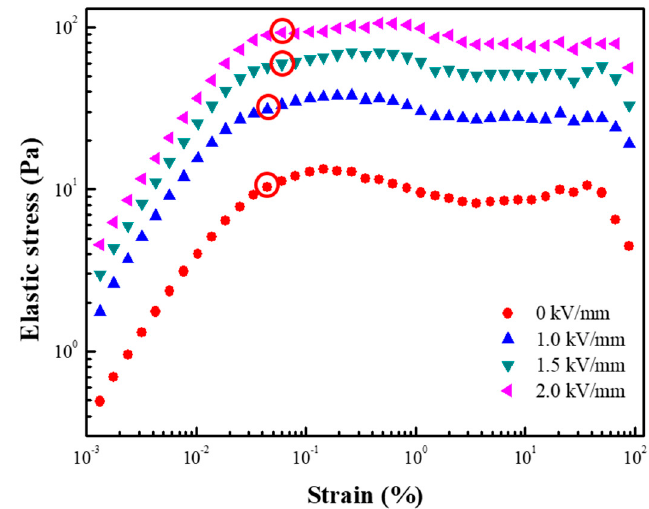
Figure 7. Elastic stress as a function of strain for PDPA / Fe 3 O 4 -based ER fluid (10 vol%, 50 cSt silicone oil). The red circles indicate the yield points.